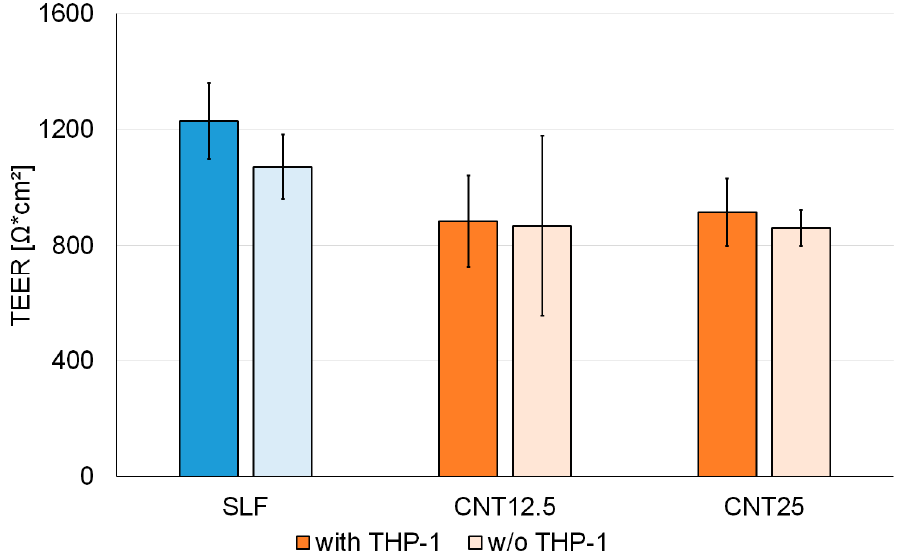
Figure 8. TEER values of EpiAlveolar™ tissues with and without THP-1 treated with control (SLF) or 12.5 and 25 µg CNT4003 particles at 7 d. Table 7. Time-dependent changes (in %) of cytokine secretion by EpiAlveolar™ tissues without THP- 1 (Epi) and with THP-1 (Epi/THP-1) upon stimulation with lipopolysaccharide (LPS) and CNT4003. Secretion of unstimulated tissues is set as 100%. Significant increases ( p < 0.05) between treated and untreated samples are indicated by an asterisk and significant decreases by a paragraph